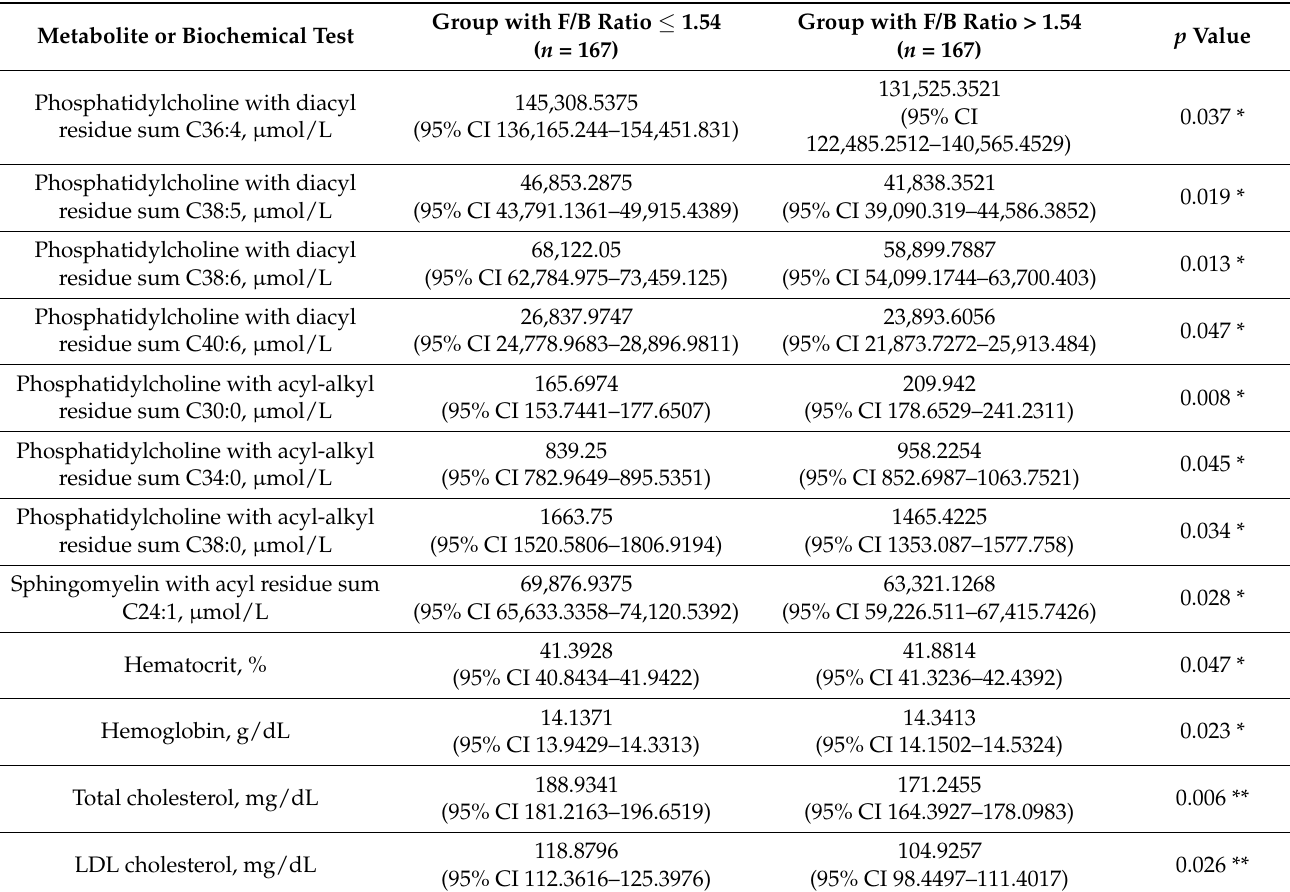
Table 6. The influence of Firmicutes/Bacteroidetes ratio on targeted metabolomics (Biocrates) and biochemical test adjusted for age, sex, CAD status, statins treatment (and) LDL cholesterol concentration. Group with F/B Ratio ≤ Metabolite or Biochemical Test